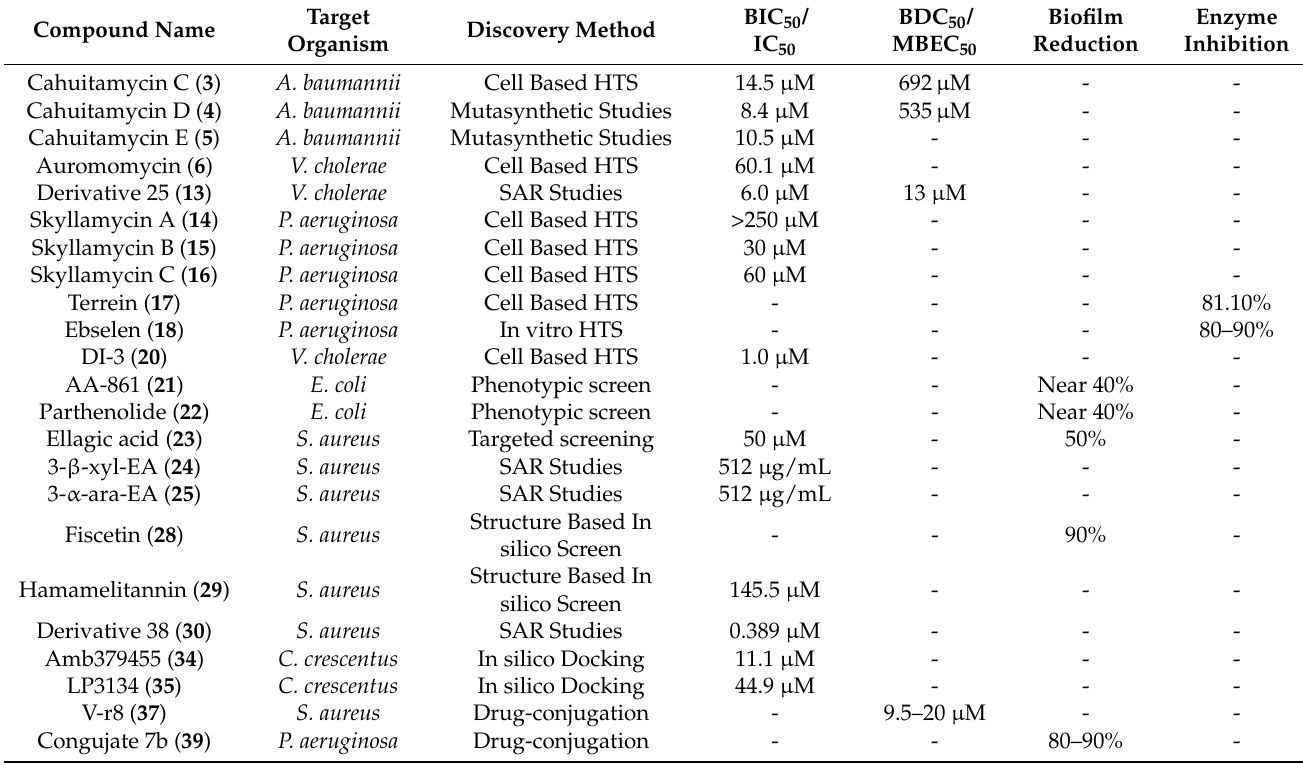
Table 1. Biofilm inhibitors discussed, their target pathogen, discovery method, and inhibitory activity. This includes biofilm inhibitory concentration (BIC50), enzymatic inhibitory concentration (IC50), biofilm dispersal concentration